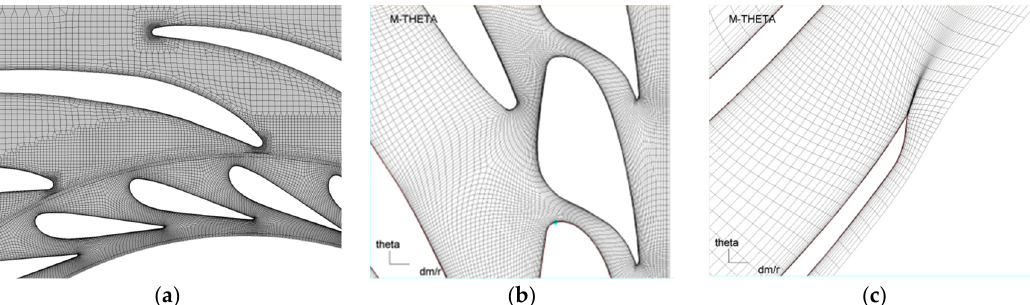
Figure 6. Improved mesh in the distributor and guide vane passages [6]. ( a ) mesh (hex dominant) in stay vane and guide vane passages at the mid ‐ plane of spiral casing; ( b ) mesh (hexahedral) in guide vane passages; and ( c ) mesh (hexahedral) in the blade passage